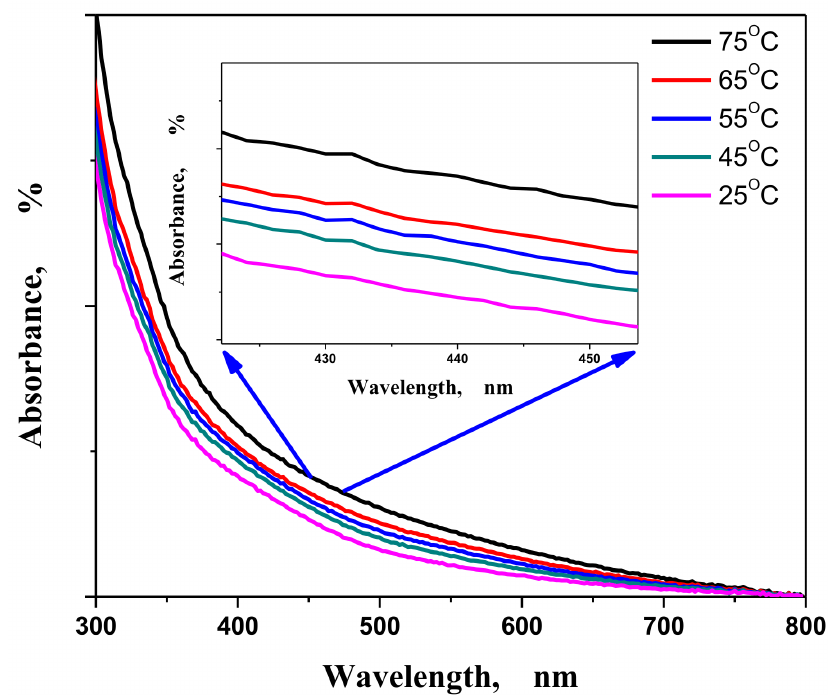
Figure 5. The effect of temperature on biosynthesis of palladium nanoparticles.